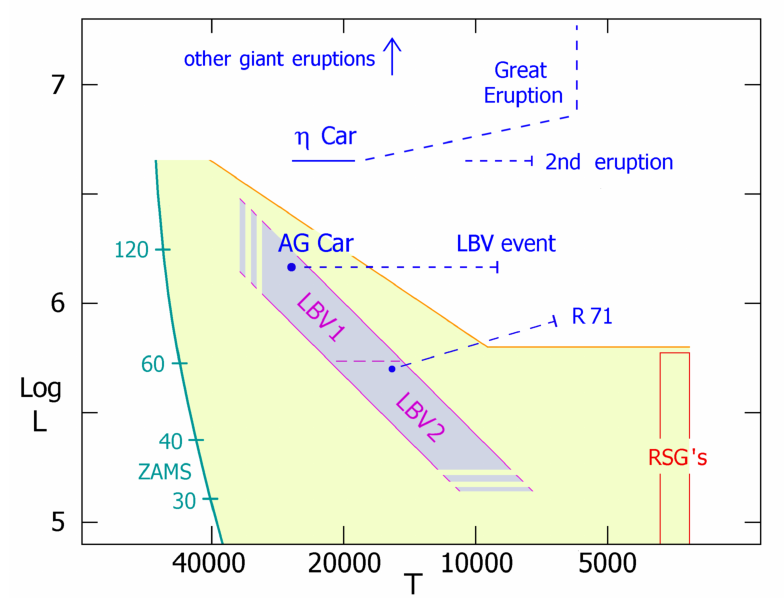
Figure 1. The empirical upper boundary and LBV instability strip in the Hertzsprung-Russell Diagram. In reality they are ill-defined and may depend on rotation and chemical composition. The interval between the LBV strip and the boundary is very uncertain. The zero-age main sequence on the left side shows initial masses, and most of a very massive star’s evolution occurs at roughly twice the initial